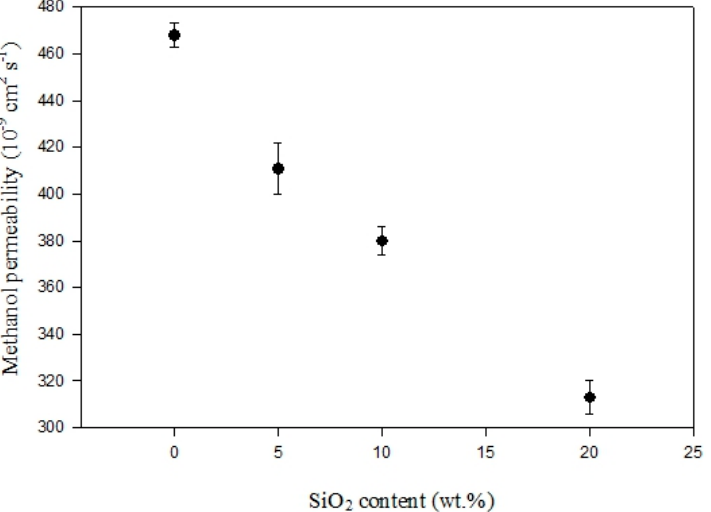
Figure 12. Methanol permeability data of the sPEEK / SiO 2 composite electrolyte membranes with different SiO 2 contents at 25 °C.